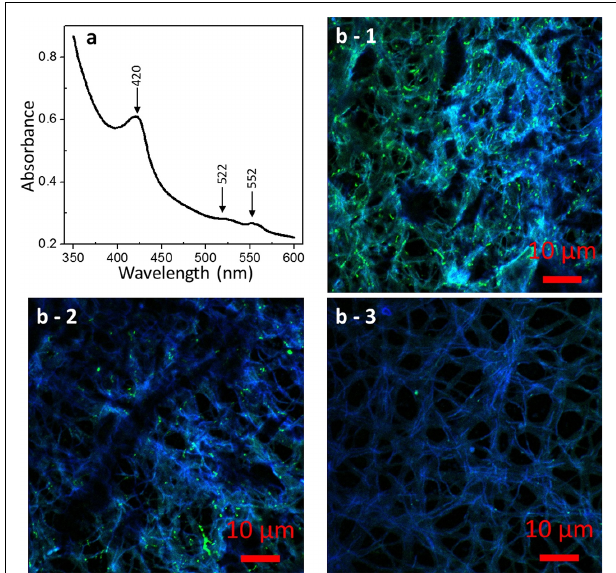
FIGURE 4 | Microscopic images of strain 110S. (a) UV/Vis spectrum of a whole cell suspension of strain 110S. Absorbance peaks for the Soret band (420 nm) and Q-band (522 and 552 nm) of c -cyts were observed. (b) Confocal micrographs of strain 110S stained with pos_148-161 (b-1) and pos_350-365 (b-2) FITC-labeled polyclonal antibodies against ARMA_0580 protein, or without primary antibody (b-3) . Scale bars indicate 10 µ m.